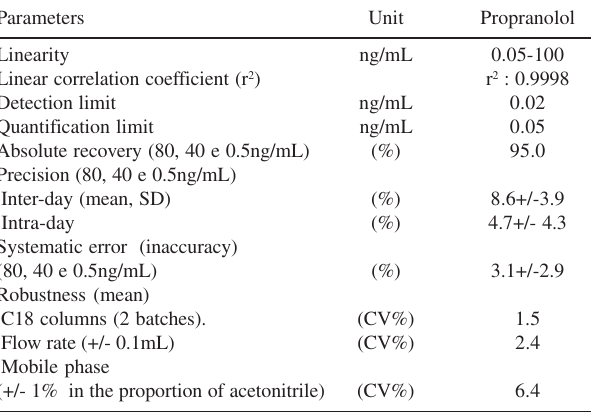
Table 3. Confidence limits of the analytical method for the determination of propranolol in plasma.